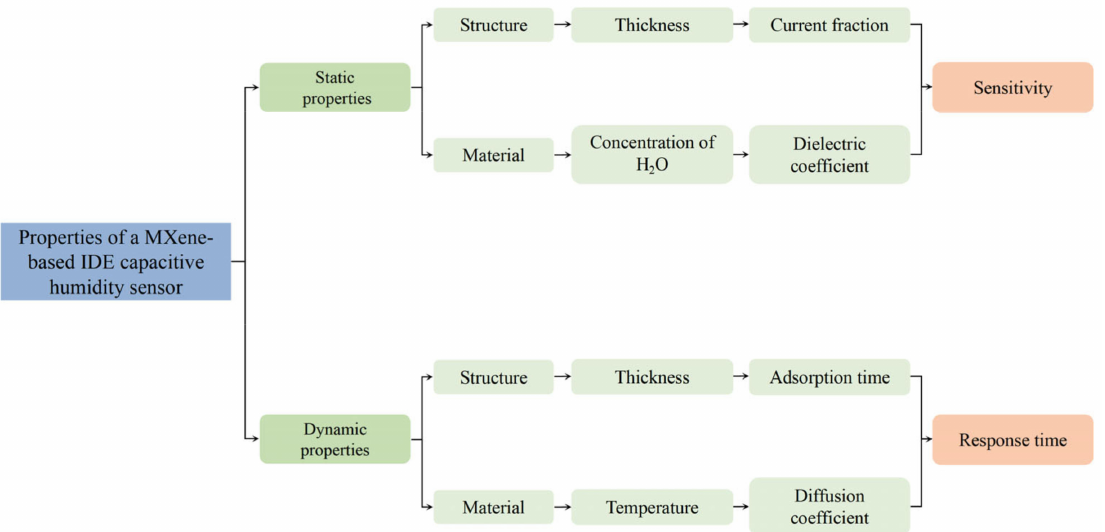
Figure 8. Schematic diagram of properties and related parameters of the MXene-based IDE capacitive humidity